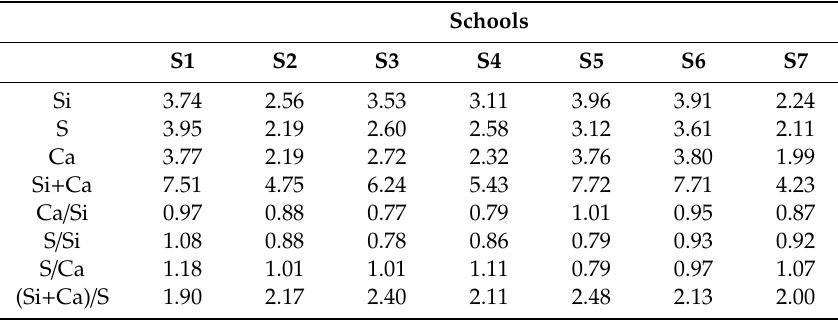
Table 4. Percentages of the di ff erent elements analyzed by mapping and quotients calculated for each